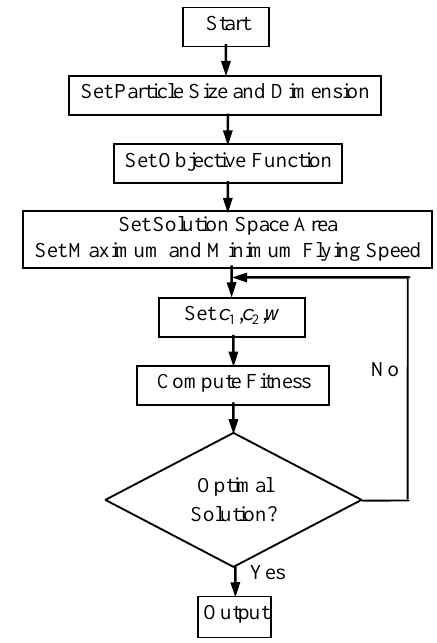
Figure 3. Flow chart of calculating the approximate values of exterior orientation elements of a single image using